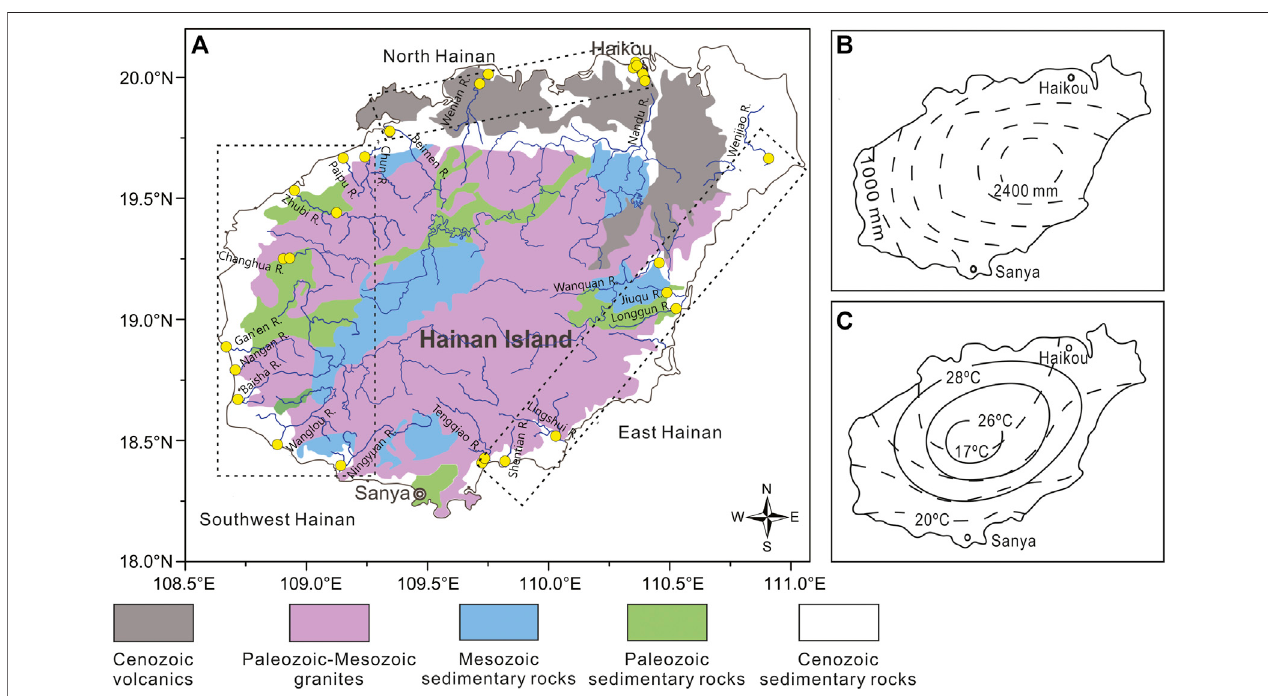
FIGURE2|(A) GeologicalmapandthelocationsofriverinesamplesontheHainanIsland.Modi fi edfromShietal.(2011)andHuetal.(2014). (B) Annualrainfalland (C) temperature ofJanuary(dashedlines)andJuly(solidlines)oftheHainanIsland(modi fi edfromhttp://gzdl.cooco.net.cn/testdetail/91943/). Thebluelinesindicatethe river networks. Note that some of the sampling sites are overlapped on the map.